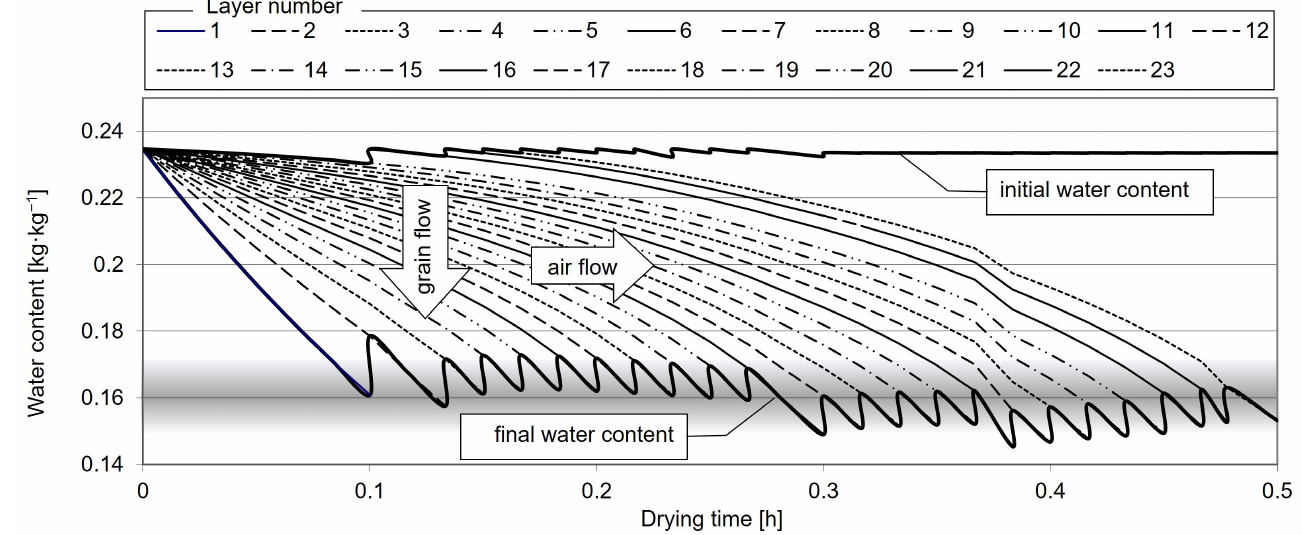
Figure 12. Simulated changes in the moisture content of successive grain layers dried in the cross-flow mode.